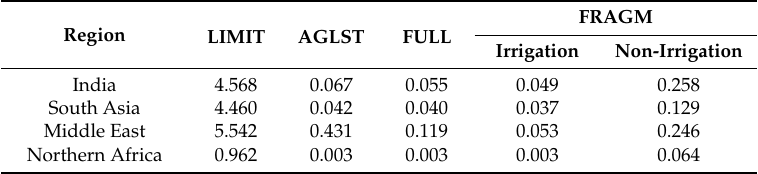
Table 3. Water scarcity rents in 2050 by region and by allocation method ($/m 3